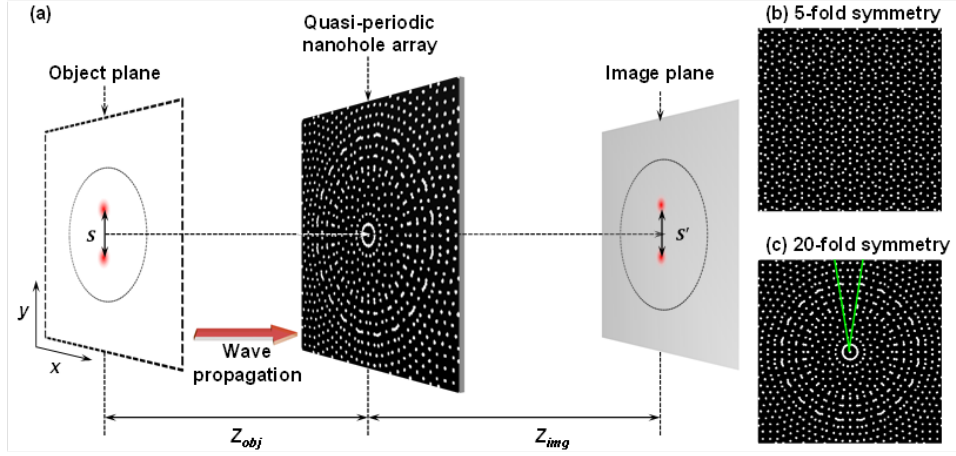
Figure 1. Imaging of two adjacent point light sources with a nanohole array lens. ( a ) In the model, two point light sources with a separation S are placed on an object plane at a distance of Z obj away from a nanohole array lens. In calculations, the size of nanohole array lenses is 50 × 50 μm 2 and the illumination wavelength of the optical sources is λ = 660 nm. Field distributions on the other side of the nanohole array lens will be obtained at different imaging distances Z img . Note that one of the field maps may reveal an imaged pattern with two imaged spots separated with a distance S ′ which can be seen as an image of the two light sources. Plates ( b ) and ( c ) schematically show the fragments of generated quasi- periodic nanohole arrays’ patterns with 5-fold and 20-fold rotational symmetry, respectively. In (c), the angle between the two green lines is π/10